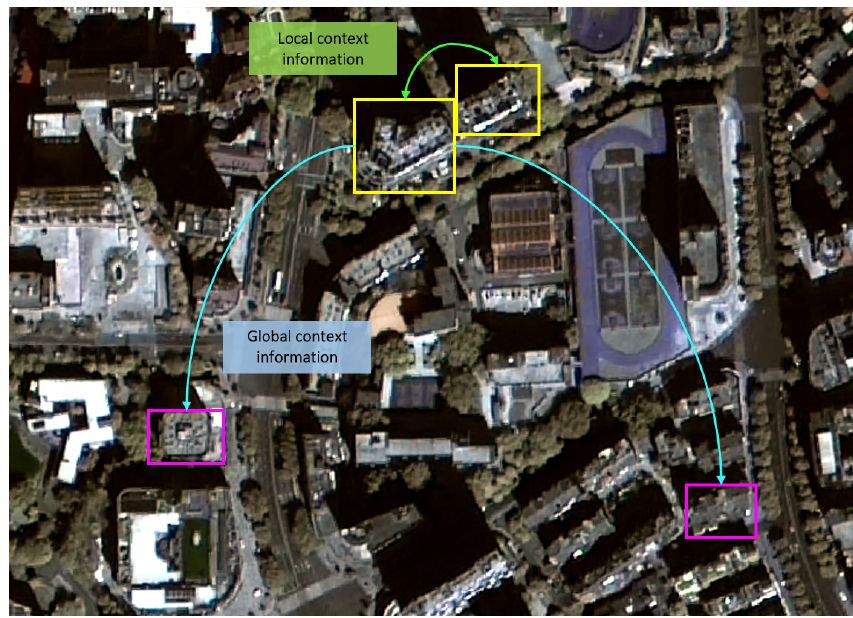
Figure 1. Illustration of contextual information in a remote sensing